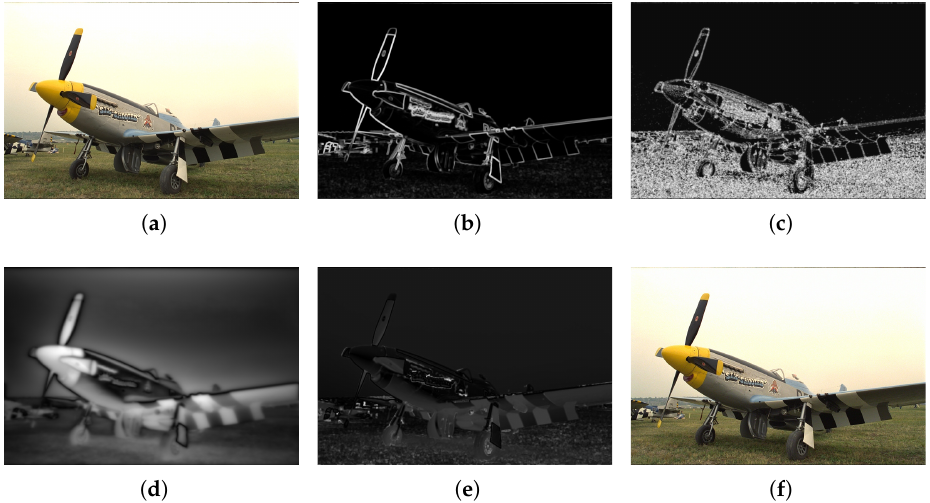
Figure 2. An example of JND generation and a contaminated image guided by JND noise: ( a ) the original image; ( b ) response map for contrast masking of Y component; ( c ) response map for pattern masking of Y component; ( d ) saliency prediction map; ( e ) JND map of Y component; and ( f ) JND- contaminated image, with PSNR = 27.00